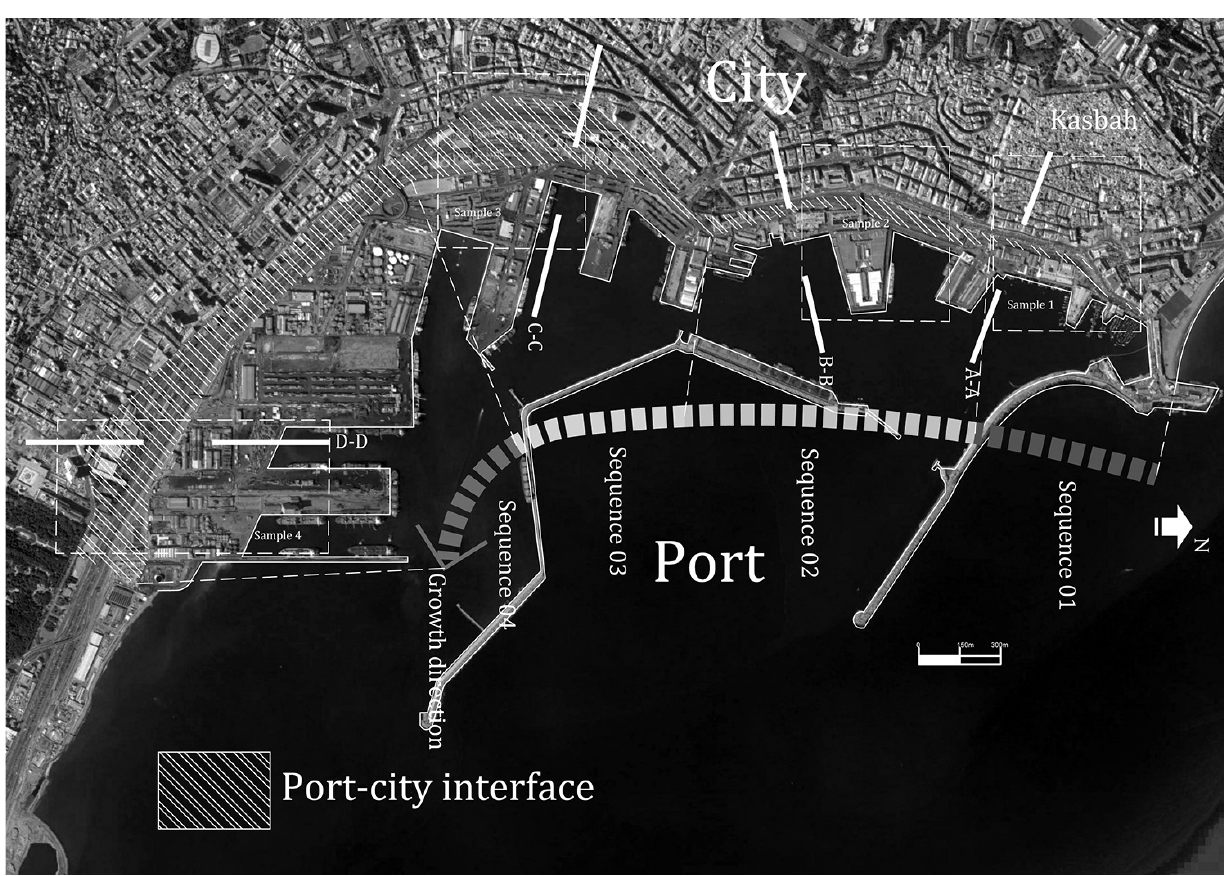
Figure 8. Map of Algiers’ current port‐city interface, divided in relevant sequences with cross‐sections. Source: Google Earth and modified by the